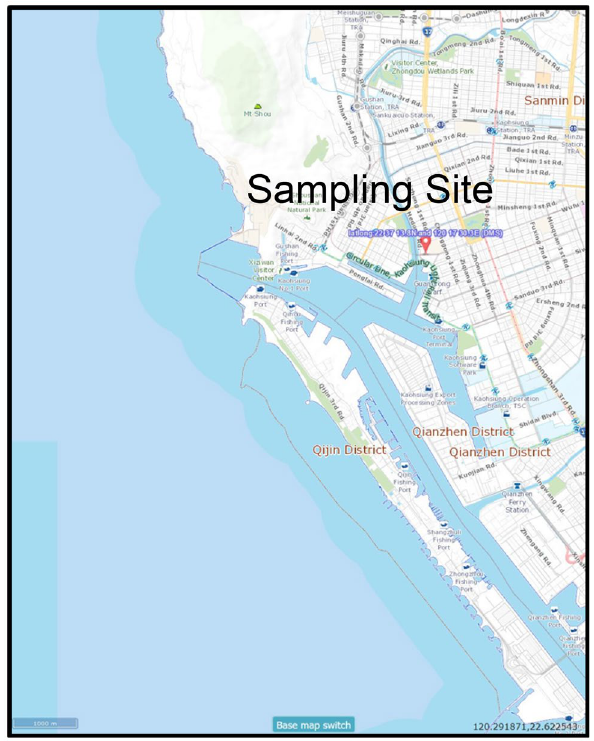
Figure 1. Sampling site selected in this study (created by using Taiwan Map Service, https ://maps.nlsc.gov.tw/).